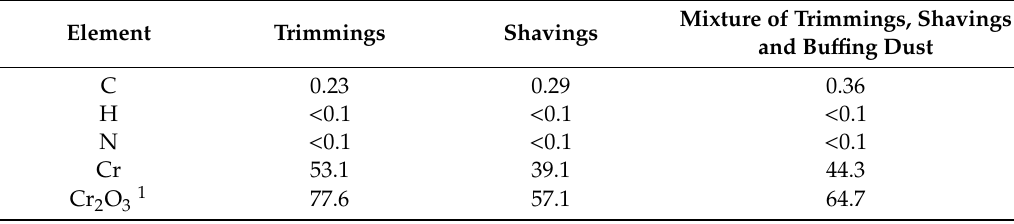
Table 2. Content of C, H, N and Cr in the ash (% (w / w) in dry basis). Element Trimmings Shavings